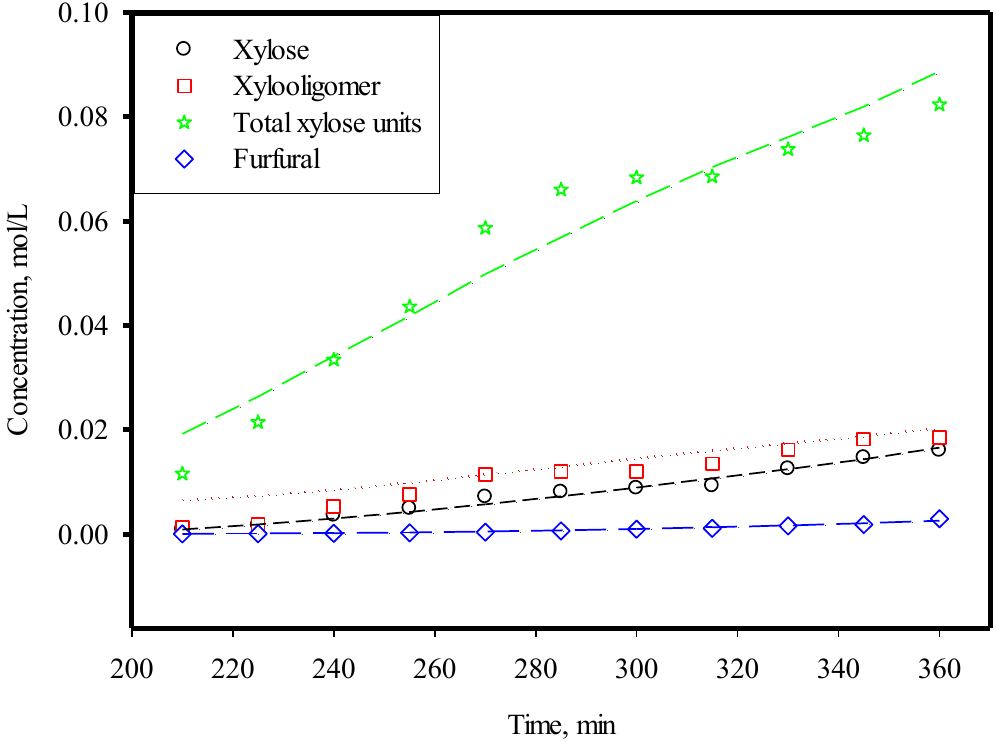
Figure 5. Variations of xylose, xylooligomer, total xylose units, and furfural as a function of extraction time. The lines are based on Equations